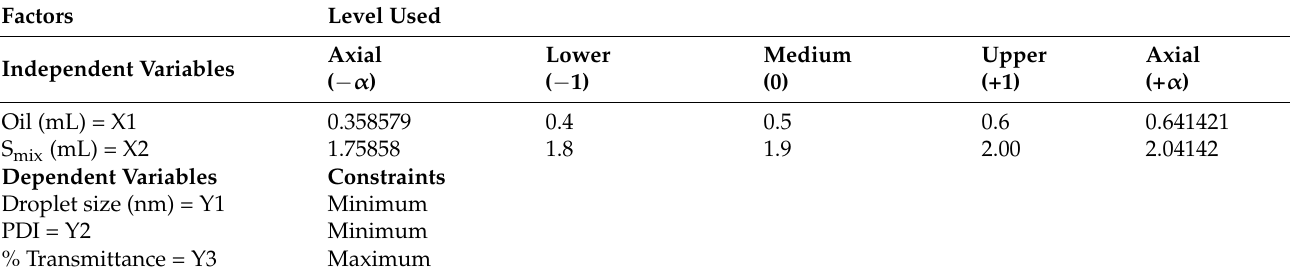
Table 1. Different level and constraints of